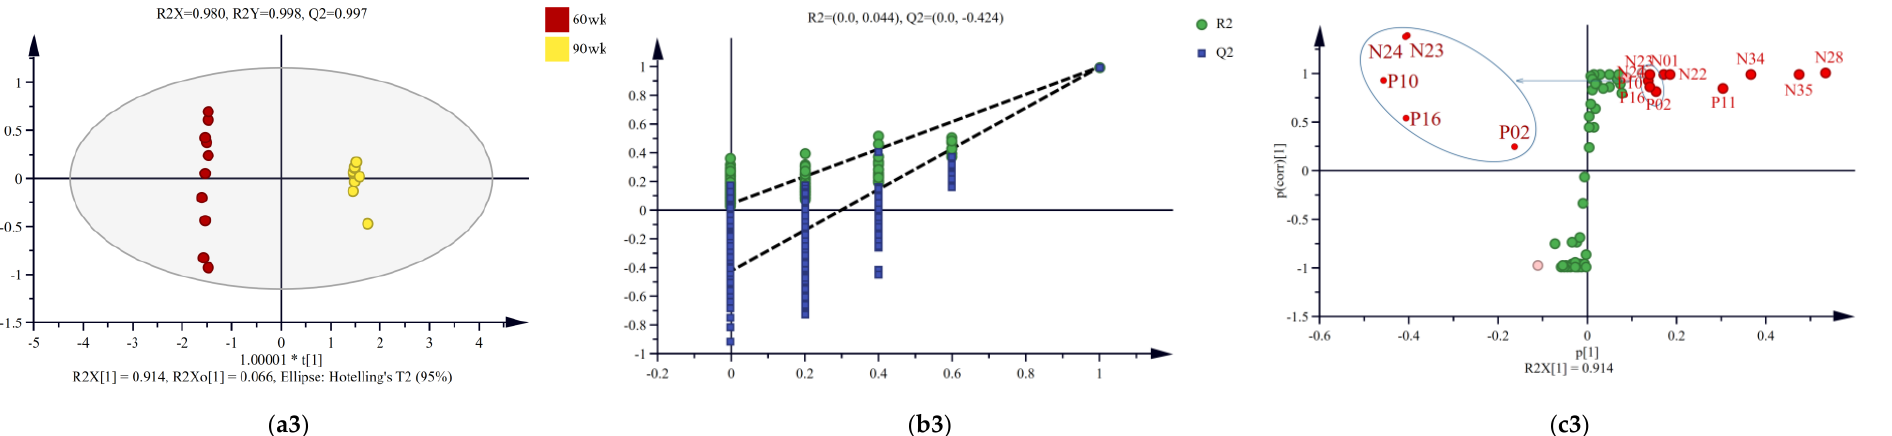
Figure 4. The OPLS-DA scores plots, permutation test plot, and corresponding S-plot of 10/90 ( a1 – c1 ), 20/90 ( a2 – c2 ), and 60/90 ( a3 – c3 ) wk models ( c1 – c3) . *, the multiplication sign. The 15 compounds with the largest VIP values in S-plot ( c1 – c3) are labeled in light red ( ), and those with VIP ≥ 1 are labeled in bright red ( ). P02, creatinine; P10, isoleucine; P11, hypoxanthine; P16, guanine; N01, lactic acid; N21, propionic acid; N22, carnosine; N23, adenine; N24, anserine; N28, inosine; N34, 5 ′ -AMP; N35, 5 ′ -IMP; N37, glutathione.